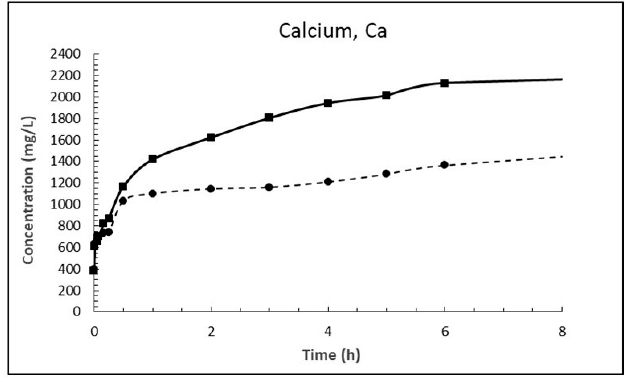
Figure 8. Concentration of calcium in sea water at T = 5 °C (dashed line) and 15 °C (solid line) as function of time after adding 1% ( w / v ) fine CaO.